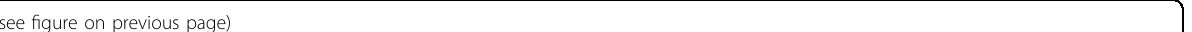
Fig. 4 CD36 mediates OxLDL uptake to promote MIF expression via the lipid peroxidation/p38/CEBPs axis in CD36 + CAFs. a Isolation of CAF subtypes from HCC tumors via fl ow cytometry. b The average proportion of CAF subtypes in human or murine HCC tumors by fl ow cytometry. c Heatmap showed speci fi c gene markers in CAF subtypes from murine and human HCC tumors. d , e The qPCR and ELISA assays showed MIF expression was higher in CD36 + CAFs among all fi broblasts. f The ELISA and western blot assays showed MIF expression was downregulated when CD36 was knockdown in CAFs. g The activity of reactive oxygen species pathway gene signatures in different CAF subclusters. h GSEA shows top enriched pathways in CD36 high vs CD36 low group and CD36 kd vs WT group. i – k Uptake of OxLDL and lipid peroxidation in CD36 + or CD36 kd CAFs was measured using fl uorescently conjugated OxLDL and fl ow cytometry. l Human CD36 + CAFs treated with vehicle Ctrl, LDL (60 μ g/mL), or OxLDL (30 or 60 μ g/mL) for 24 h and then washed in PBS and incubated with BODIPY 581/591 C11 for the lipid peroxidation assay. m CD36 + or CD36 kd CAFs were treated with vehicle Ctrl, OxLDL (60 μ g/mL), Toco (200 mM), SSO (100mM), a combination of OxLDL (60 μ g/mL) and Toco (200 mM), or a combination of OxLDL (60 mg/mL) and SSO (100 mM) for another 24 h. p38 phosphorylation (p-p38) was measured by fl ow cytometry, and the MFI of p-p38 was normalized to Ctrl. n The expression of p-p38 among CD36 + CAFs, CD36 kd CAFs and CD36 – CAFs from in vivo HCC murine models. o CD36 + CAFs were treated with vehicle Ctrl, OxLDL (60 μ g/mL), SSO (100 mM), p38 inhibitor SB203580, a combination of OxLDL and SSO, or a combination of OxLDL and SB203580 for another 24 h. MIF secretion was measured by ELISA experiments, and the expression of MIF was nomalized to Ctrl. p CEBPA and CEBPD in CD36 + CAFs modulated the transcriptional expression of MIF by ChIP assays. Data are mean ± s.d. of n = 3 independent experiments. * P < 0.05, ** P < 0.01, *** P < 0.001 by Student ’ s t test. n = 3 biological replica t es. Data shown as mean ± S.E.M., one-way ANOVA following multiple comparison test was used, *** P < 0.001, ** P < 0.01, * P < 0.05, and ns not signi fi